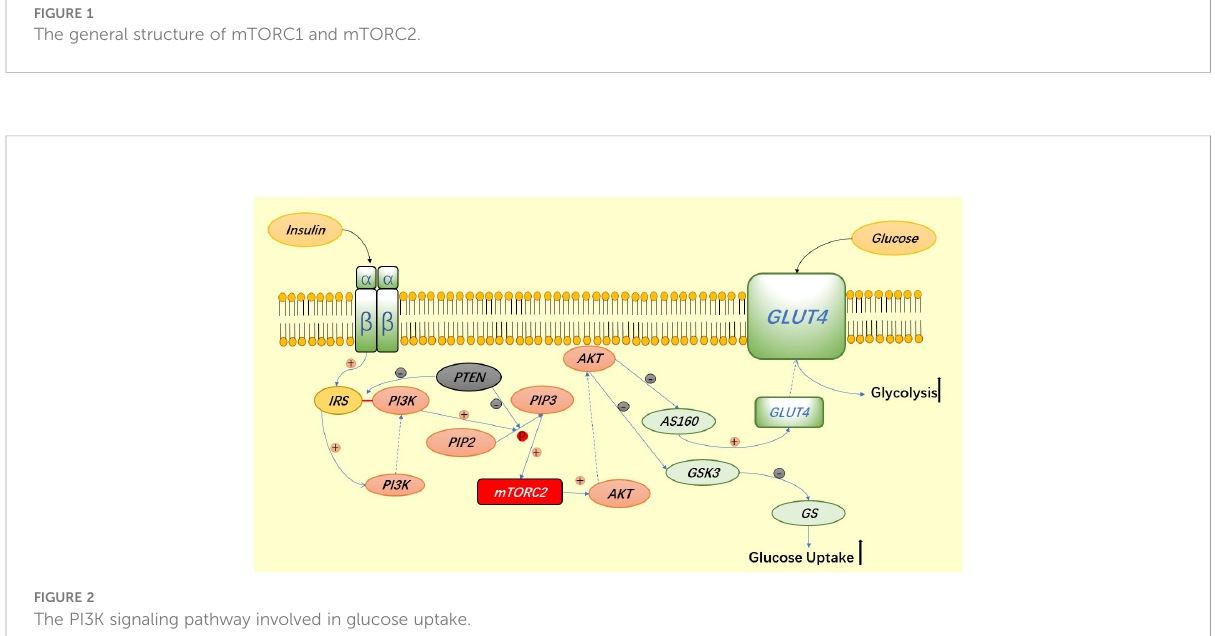
FIGURE 2 The PI3K signaling pathway involved in glucose